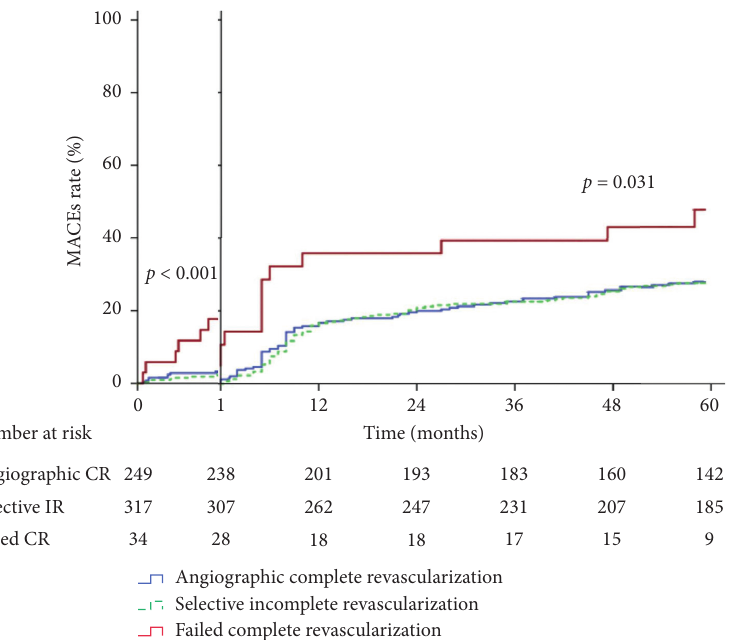
Figure 2: Kaplan-Meier curve of 5-year MACEs by revascularization status. Table 2: Five-year follow-up outcomes in patients with heart failure with multivessel disease according to revascularization strategies.